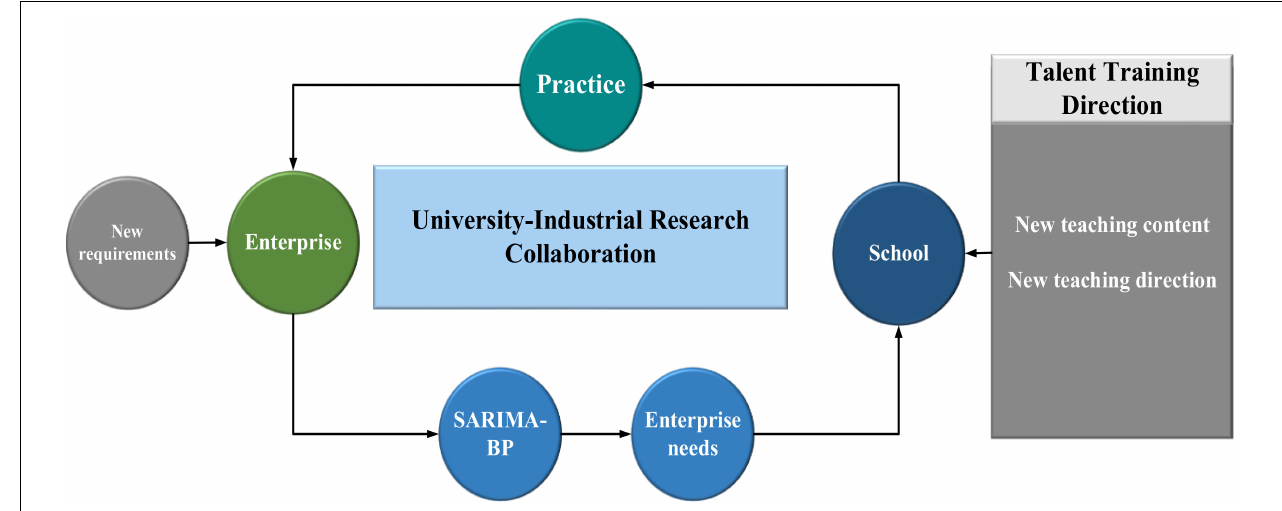
FIGURE 8 | The use of the SARIMA-BP algorithm for talent training under “University-Industrial Research